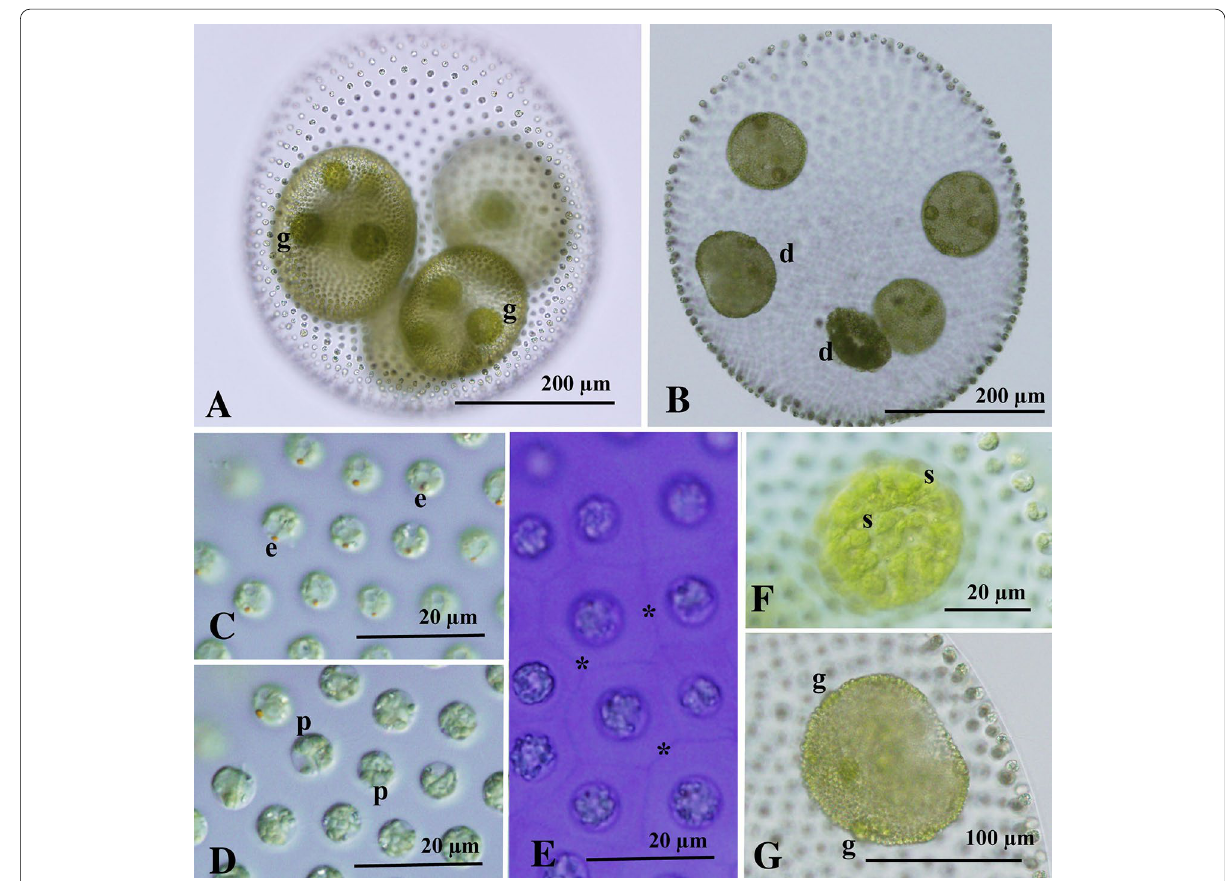
Fig. 1 Asexual spheroids of Volvox africanus G.S. West strains 1101-NK-1 ( A ) and 1101-NZ-11 ( B – G ) from Thailand. A , B , E , G Bright-field microscopy. C , D , F Nomarski differential interference contrast microscopy. A Parental spheroid containing daughter spheroids with gonidia (g). B Parental spheroid with developing embryos (d). C – E Part of spheroids. C Surface view of somatic cells showing an eyespot (e). D Optical section of somatic cells showing a pyrenoid (p) in the chloroplast. E Front view of somatic cells with individual sheaths (asterisks). Stained with methylene blue. F Surface view of gonidium showing radial striations (s). G Pre-inversion embryo or plakea. Note that differentiation of gonidia (g) of the next generation is